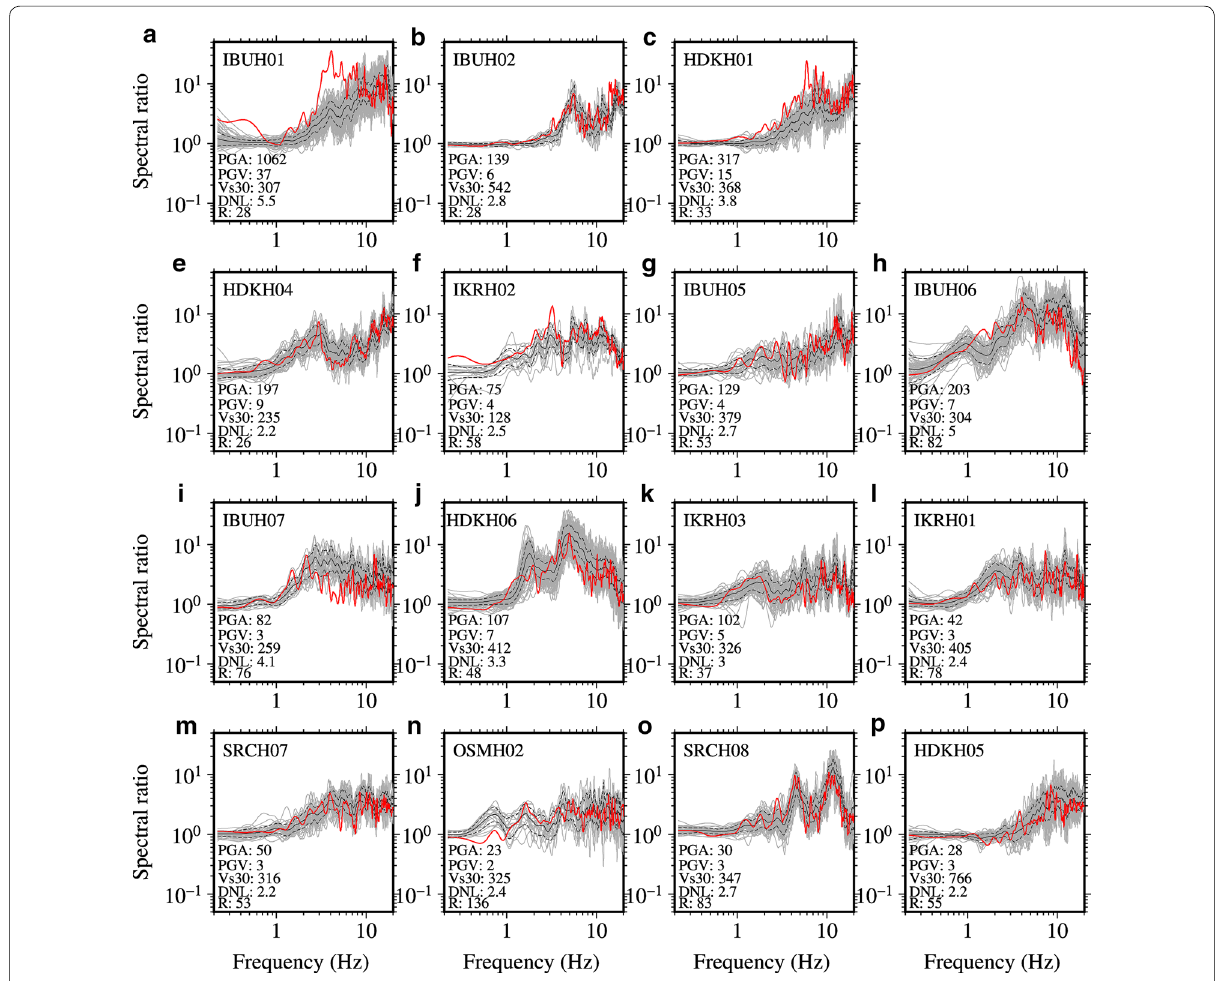
Fig. 7 Comparison of surface-to-borehole spectral ratios of vertical component recordings during weak-motions (gray lines) and those during the mainshock (red lines) at KiK-net sites. The plots are arranged in order of the sites plotted in Fig. 5 (i.e., decreasing horizontal vector PGAs from top-left a to bottom-right p panels). Solid black lines denote mean spectral ratios for weak-motions and dashed gray lines one standard deviation. The vertical PGA in units of cm/s 2 , vertical PGV in units of cm/s, Vs30 in units of m/s, DNL values, and fault-to-site distance ( R ) in units of km are also included for each site. Note that the plot for site IBUH03 is not available due to malfunction of the vertical component instrument at underground. See Fig. 3 for site